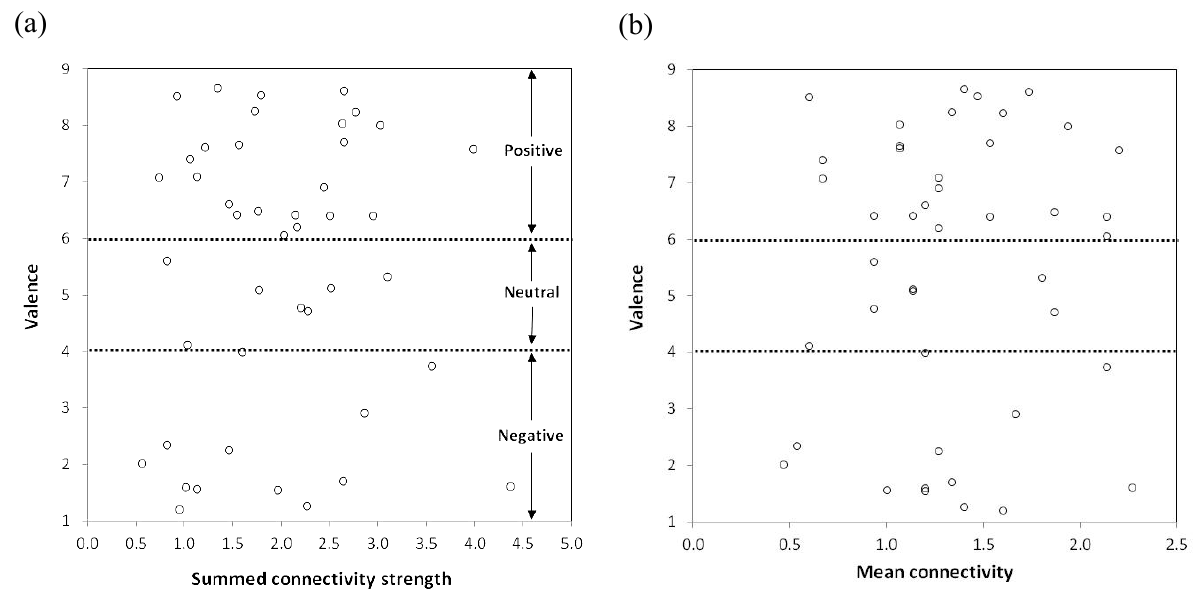
Figure 1 . Scatterplots showing (a) the relationship between valence (mean valence of the words in each DRM list) and summed connectivity strength (sum of all pair strengths within each list); (b) the relationship between valence and mean connectivity (mean number of connections across the 15 items in each list). Each data point represents one of 44 DRM lists.